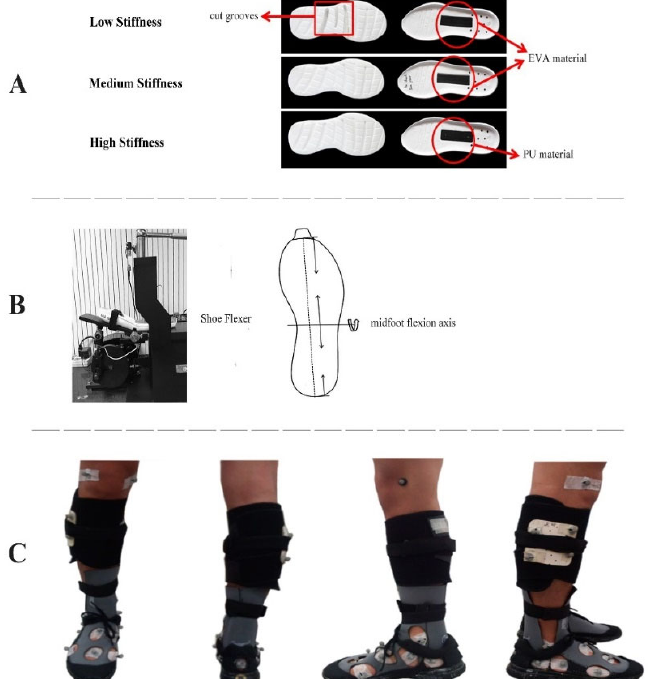
Figure 1. ( A ) Constructions of shoe conditions (low, medium, and high), with ethylene-vinyl acetate copolymer (EVA) or thermoplastic polyurethane (TPU) plate in the midfoot, ( B ) Bending axis of midfoot mechanical flexion test, and ( C ) Marker placement on the body with the subject shod.